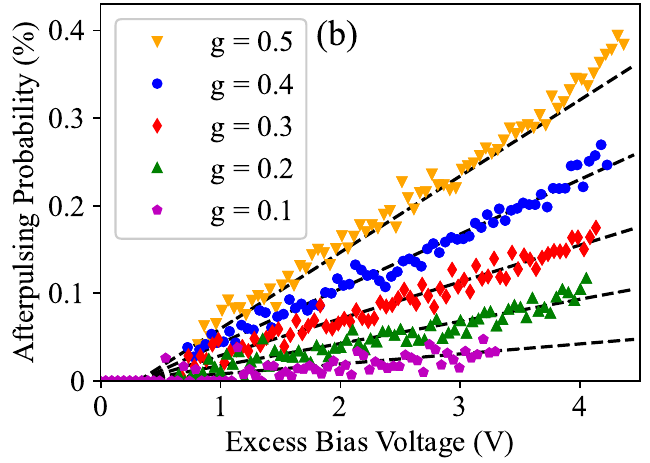
Figure 9. Afterpulsing probability as a function of the gate-ON time ( a ) and the excess bias voltage ( b ) at different duty cycle ( g )